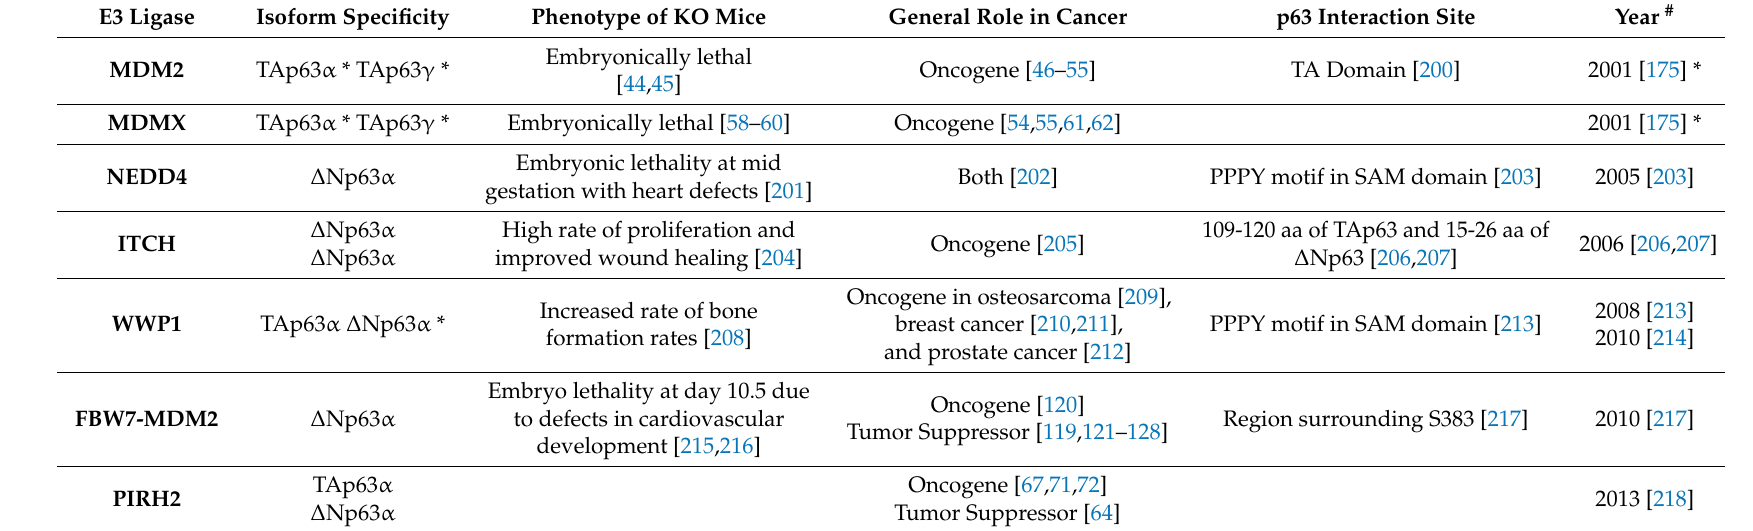
Table 3. Ubiquitin E3 Ligases for